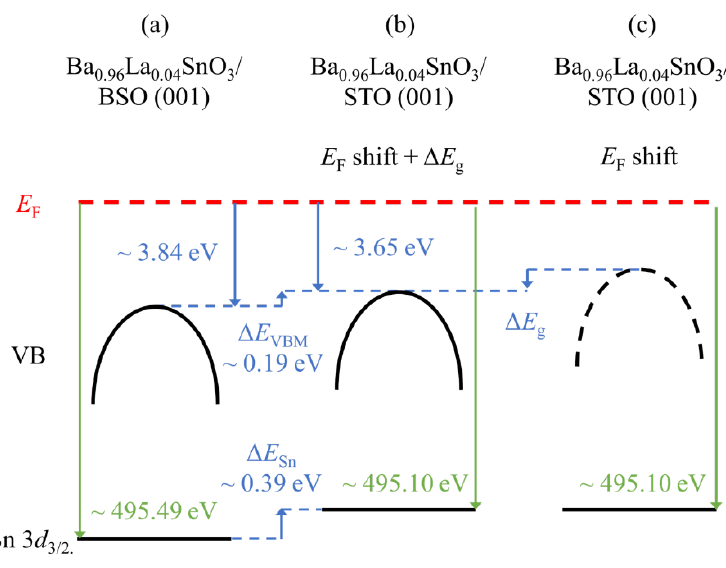
Figure 5. Schematic electronic band structures of ( a ) Ba 0.96 La 0.04 SnO 3 /BSO (001), ( b ) Ba 0.96 La 0.04 SnO 3 /STO (001) with the E F shift and the restored band gap ( ∆ E g ), and ( c ) Ba 0.96 La 0.04 SnO 3 /STO (001) with only the E F shift. These band schematics include the valence band (VB), its maximum (VBM), and a Sn 3 d 3/2 core level (Sn 3 d 3/2 ).